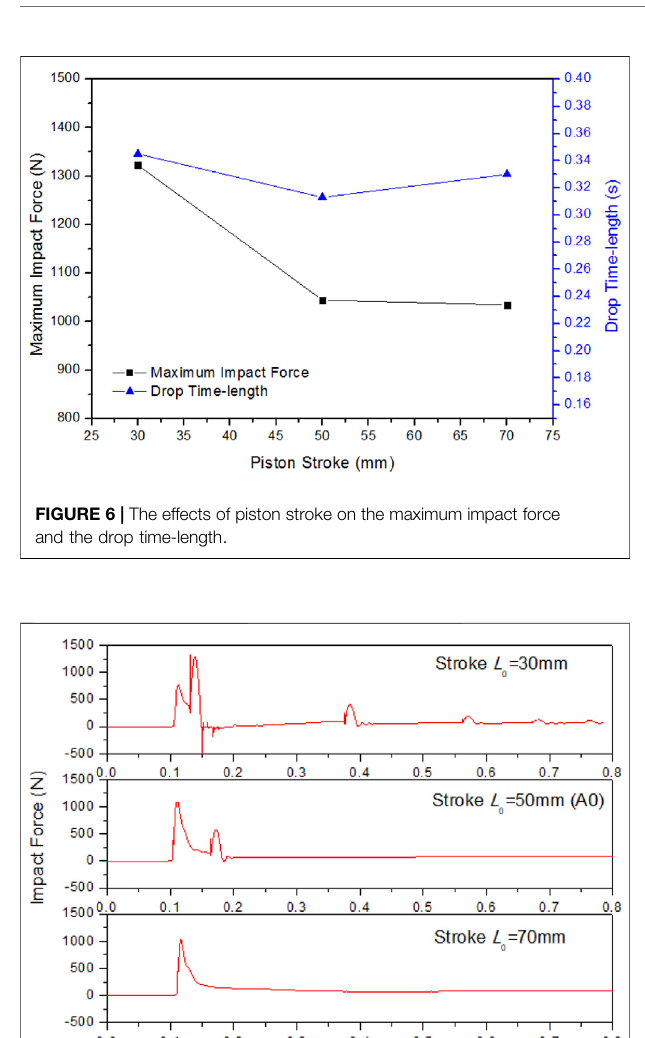
FIGURE 9 | The effects of HolesDiameter on the maximum impact force and the drop time-length.